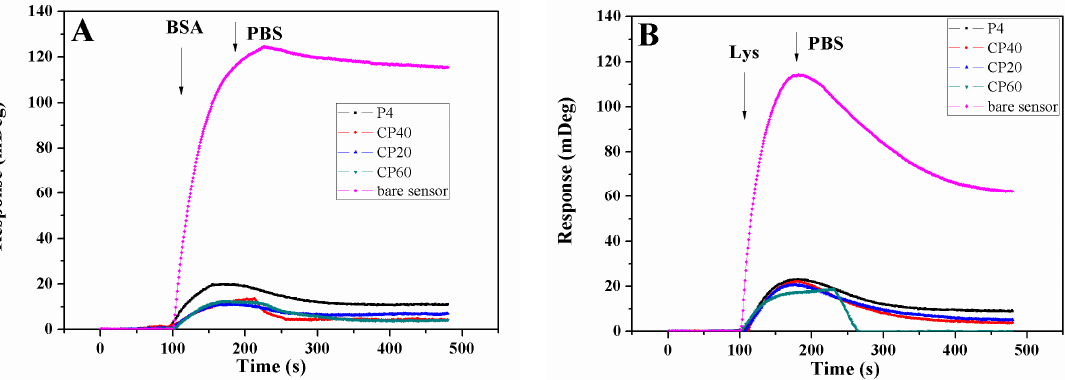
Figure 6. Adsorption profiles of BSA ( A ) and Lys ( B ) on bare sensor for P4, CP20, CP40, and CP60 polymers.